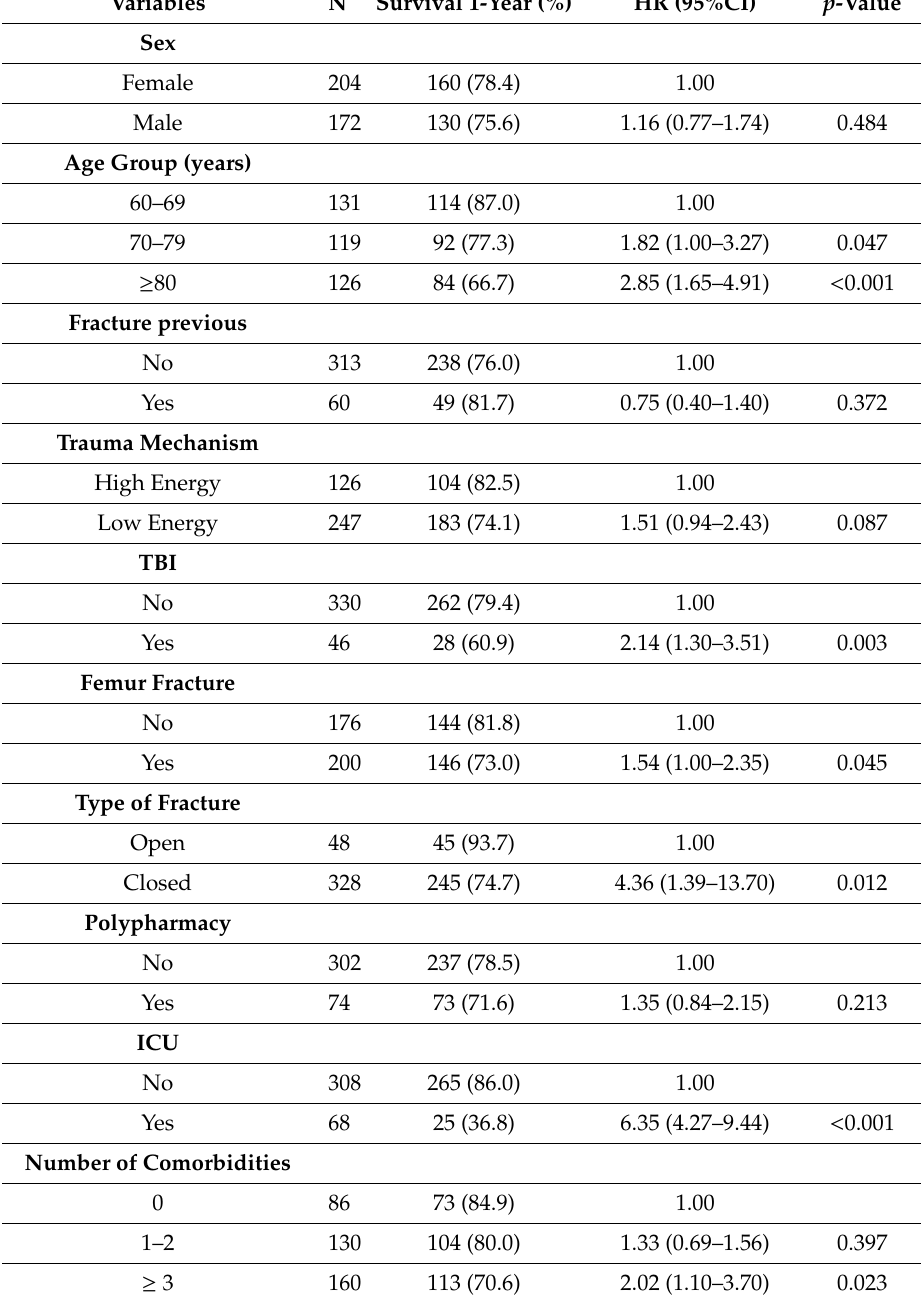
Table 3. Analysis of factors associated with survival in hospitalized elderly with bone fractures in Goi â nia, Central Brazil (2016 /